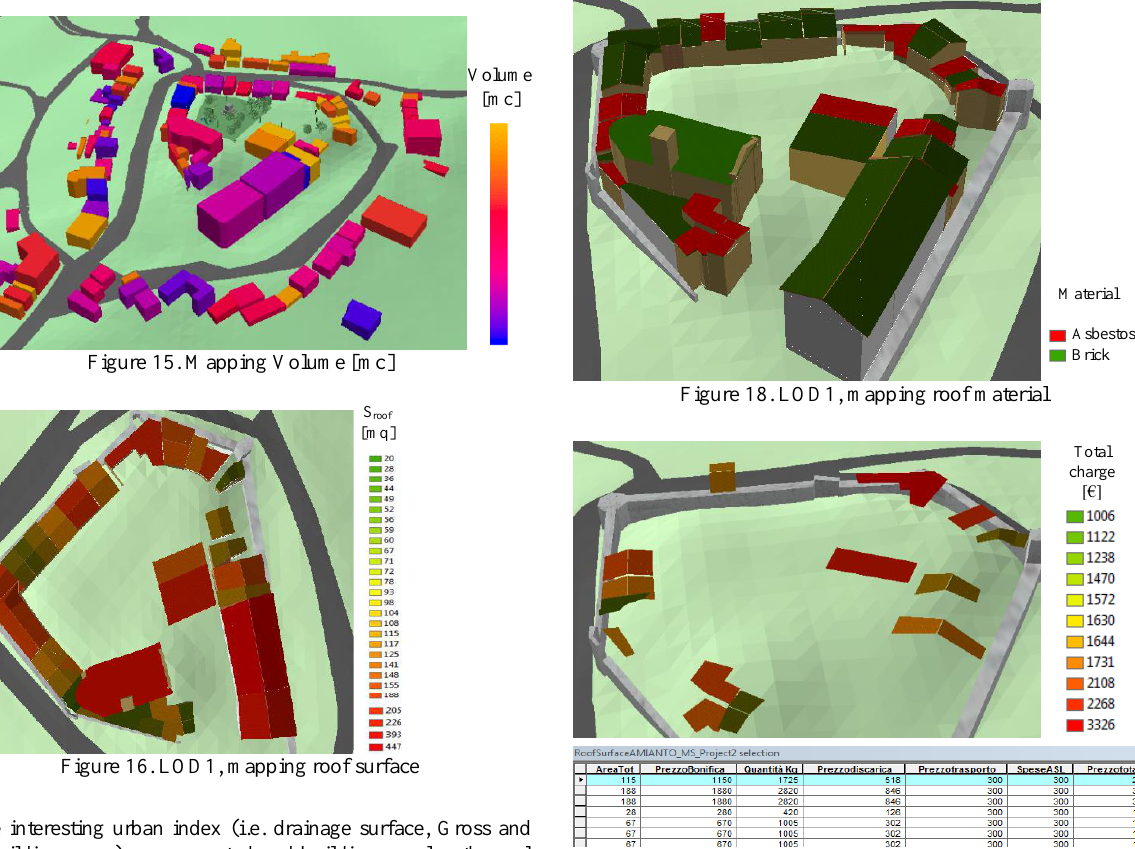
Figure 19. LOD1 Simulation: asbestos and home